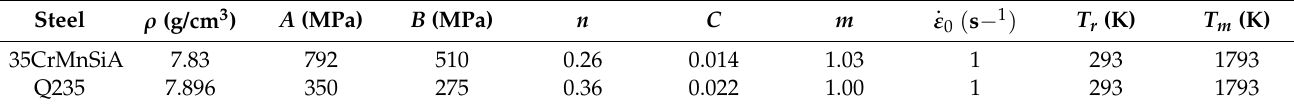
Table 4. Material constants for 35CrMnSiA and